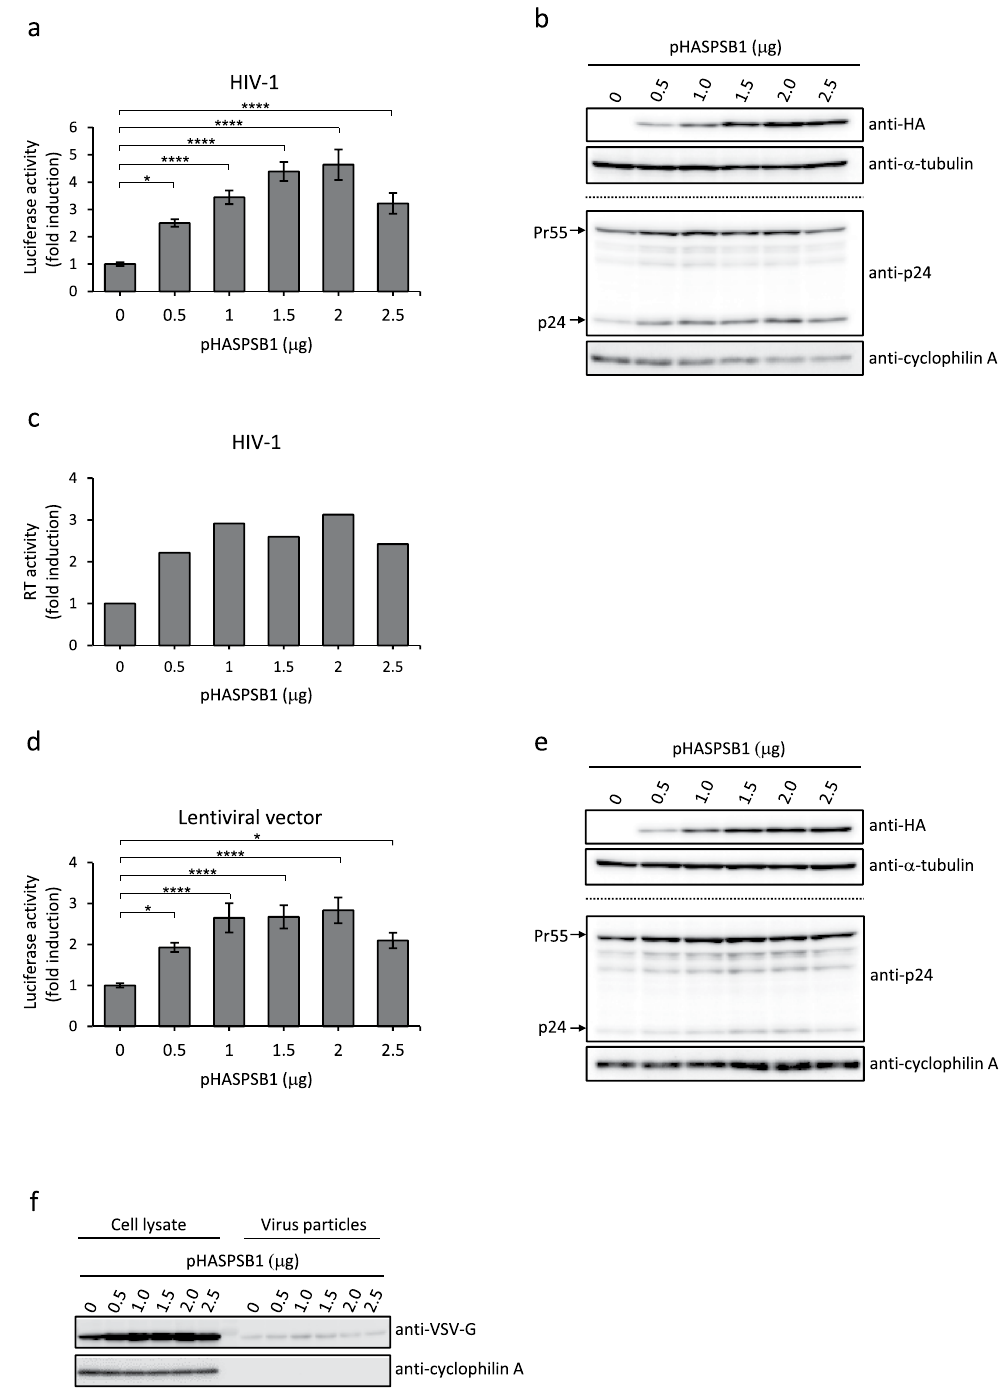
Figure 1. SPSB1 increases production of HIV-1 and lentiviral vector. ( a ) Approximately 1.5 × 10 6 HEK293T cells were co-transfected with 1 μ g of pNL4-3 and the indicated amounts of pHASPSB1 and/or pIRES-PURO empty vector (EV) so that the effector plasmids totaled 2.5 μ g. HIV-1-containing culture supernatants of transfected cells were harvested and used to infect TZM-bl cells. The luciferase activity was normalized against the protein concentration and the results are shown as fold-increase compared to the control (0 μ g of pHASPSB1). ( b ) Transfected HEK293T cells shown in Fig. 1a were harvested. Cell lysates were subjected to western blotting with the indicated antibodies. The same set of 30 μ g of lysates was subjected to western blotting using two membranes; one was probed with anti-HA antibody and then reprobed with anti- α -tubulin antibody; the other was probed with anti-HIV-1 p24 antibody and then reprobed with anti-cyclophilin A antibody. One set of representative data shown in Fig. 1a is shown. ( c ) RT activity in the supernatants used in Fig. 1b was measured and the results are shown as fold-increase compared to the control (0 μ g of pHASPSB1). ( d ) Approximately 1.5 × 10 6 HEK293T cells were co-transfected with 0.4 μ g of pHCMV-VSV-G, 0.9 μ g